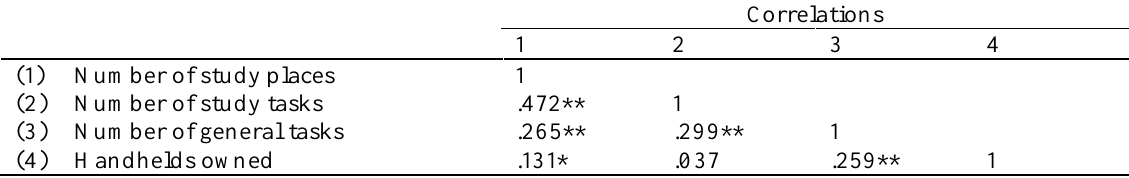
Correlation Matrix for Students Using Handheld Devices for Learning (n=294)